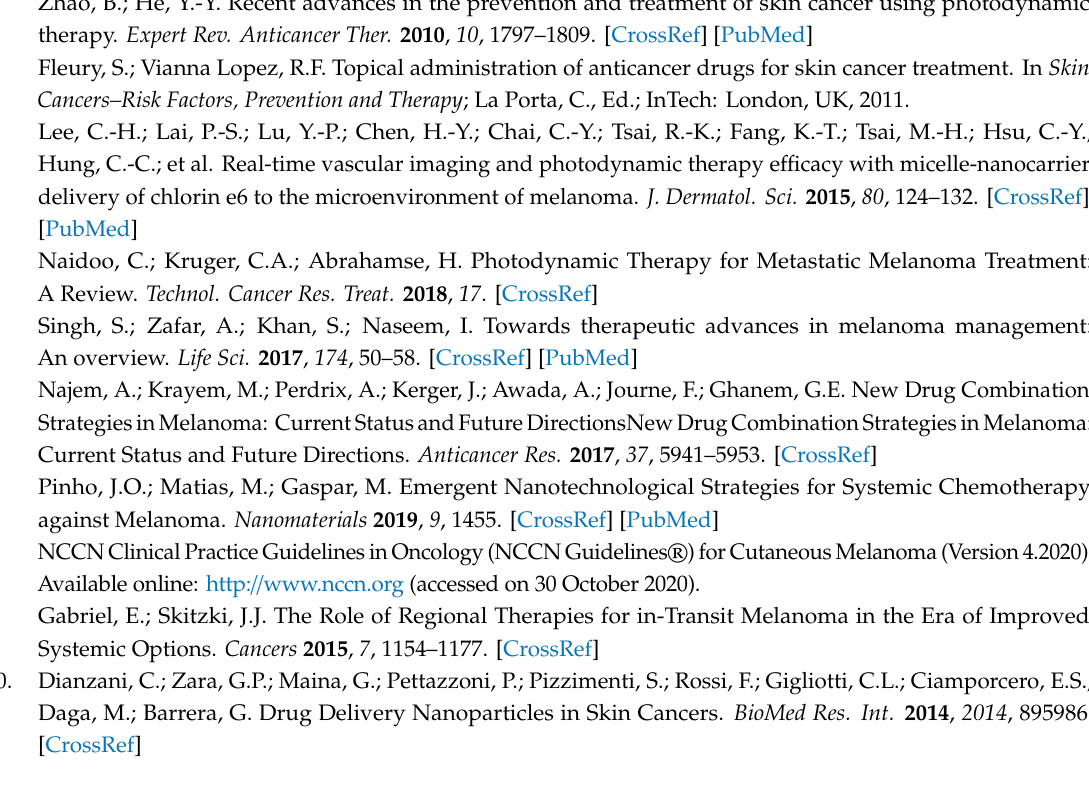
Figure S1: 1 H NMR of C 7 CO-HTMG, Figure S2: 1 H NMR of C 9 CO-HTMG, Figure S3: 1 H NMR of C 11 CO-HTMG, Figure S4: 1 H NMR of C 13 CO-HTMG, Figure S5: Di ff erential scanning calorimetry (DSC) of compound C 7 CO-HTMG at di ff erent scanning rates, Figure S6: Di ff erential scanning calorimetry (DSC) of compound C 9 CO-HTMG at di ff erent scanning rates, Figure S7: Di ff erential scanning calorimetry (DSC) of compound C 11 CO-HTMG at di ff erent scanning rates, Figure S8: Di ff erential scanning calorimetry (DSC) of compound C 13 O-HTMG at di ff erent scanning